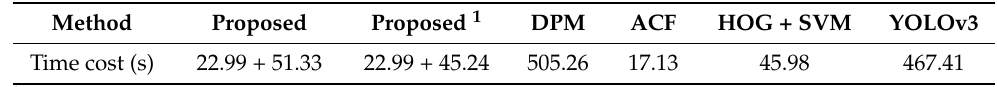
Table 12. The time cost required to detect the INRIA test